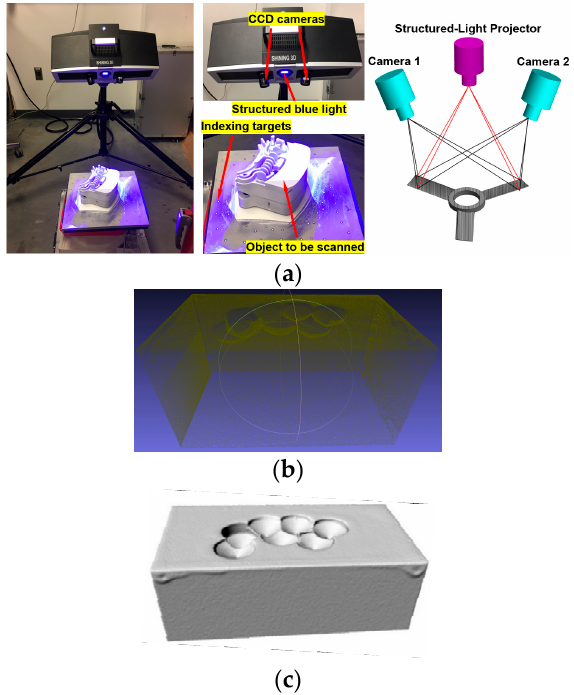
Figure 5. ( a ) 3D scanning setup; ( b ) reconstructed point cloud; ( c ) reconstructed STL model.